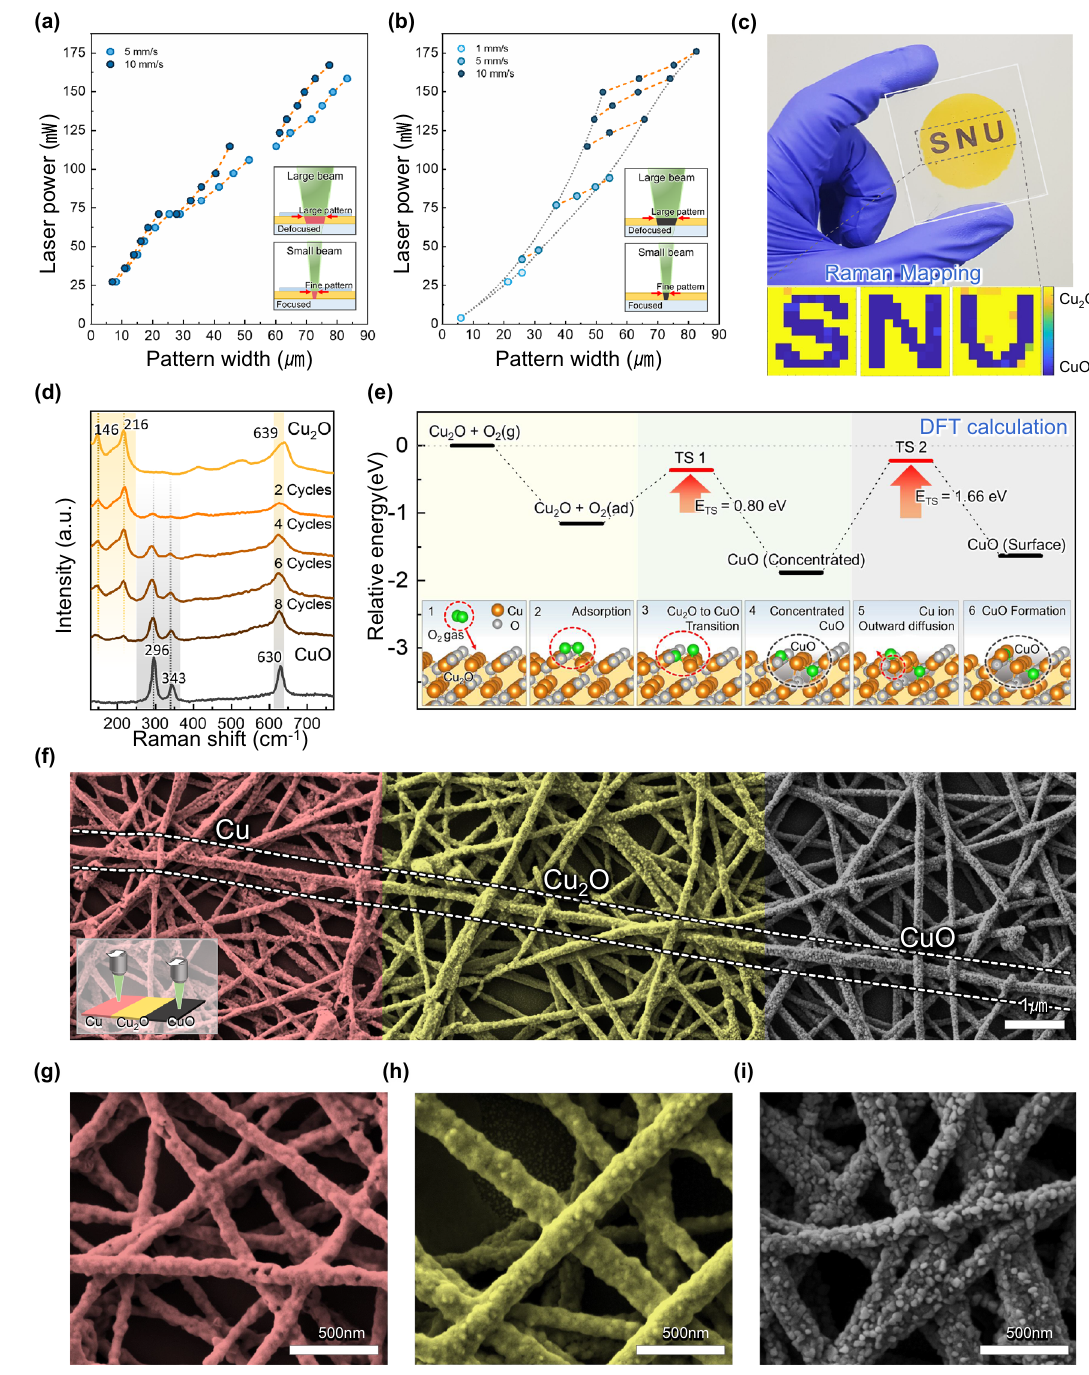
Fig. 2 a An increase in laser-reduced CuNW pattern width according to laser power. b An increase in laser-oxidized CuONW pattern width according to laser power. c Optical image of Cu 2 ONW, CuONW pattern, and quantitative Raman mapping image investigated by 121 points data at 1 mm intervals (scale bar: 500 cm). d Raman spectroscopy of laser oxidation at different scan cycles at 125 mW power and 10 mm s −1 scan- ning speed. e DFT model for theoretical investigation of Cu 2 O to CuO transition. The six inset schematics depict the oxygen and copper atoms move as oxidation proceeds. f SEM image of monolithic CuNW, Cu 2 ONW, and CuONW network, the left red area Cu, central area Cu 2 O, and right area CuO. The inset schematic describes the process for making a monolithic structure (scale bar: 1 µm). g SEM image of CuNW. h SEM image of Cu 2 ONW. i SEM image of CuONW (scale bar: 500